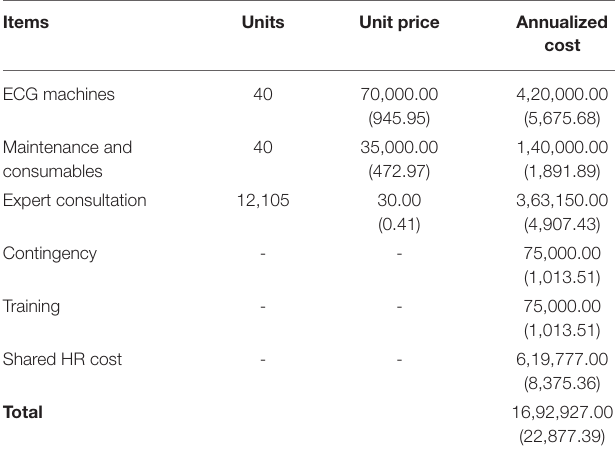
TABLE 2 | Details of the program cost in INR